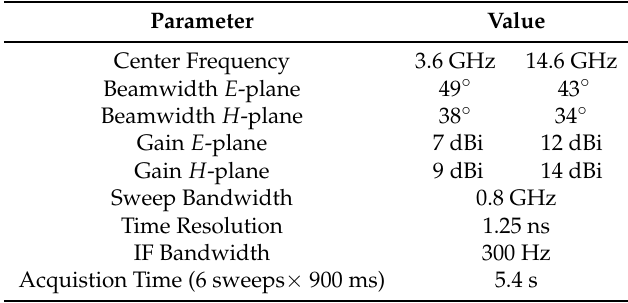
Table 1. Measurement